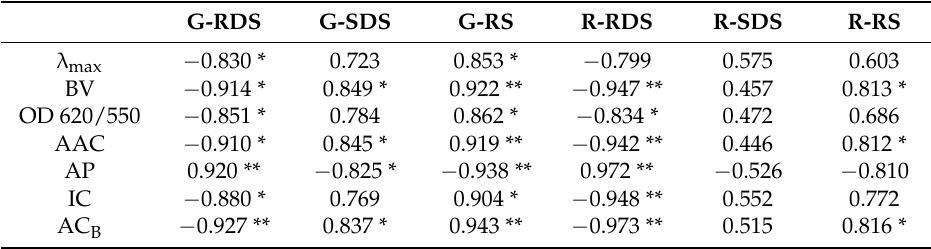
Table 7. Pearson correlation coefficients between molecular structural parameters and in vitro digestion properties of starches a